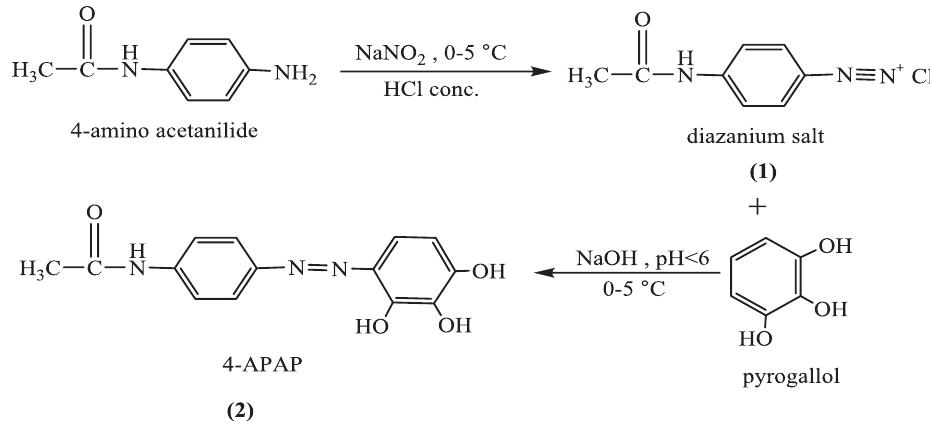
Figure 1: Synthetic rout of 4-APAP.